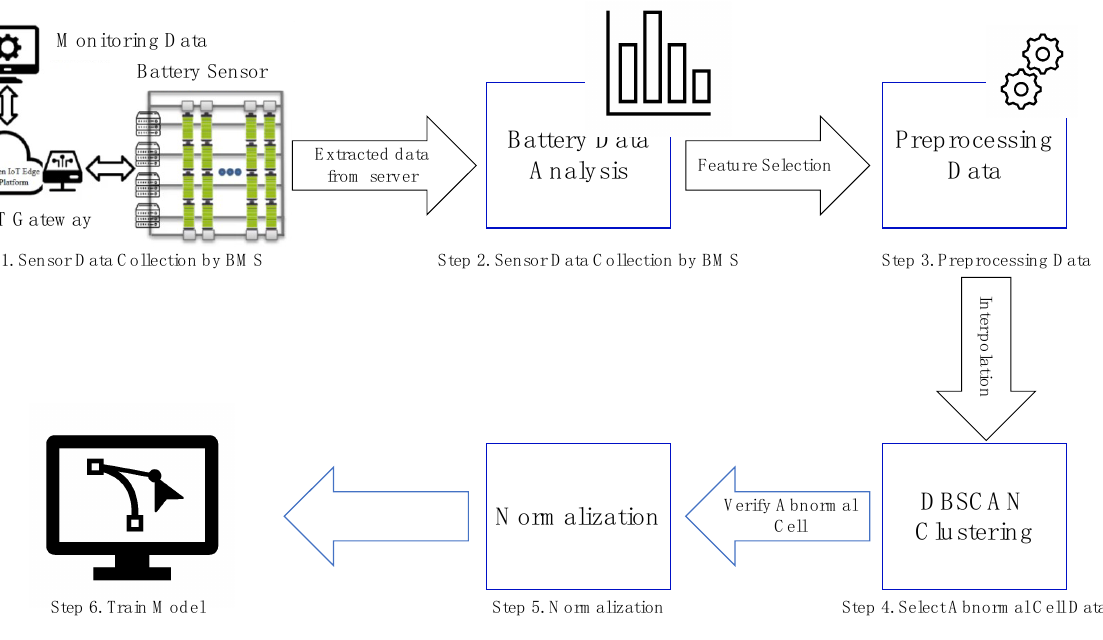
Figure 1. Method flow diagram .